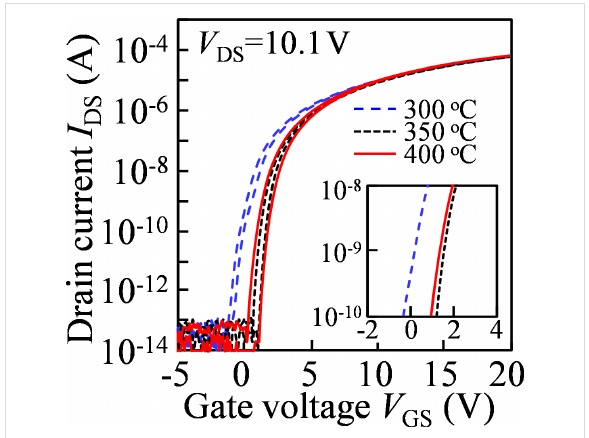
Figure 1: Transfer characteristics of the devices annealed at different temperatures.